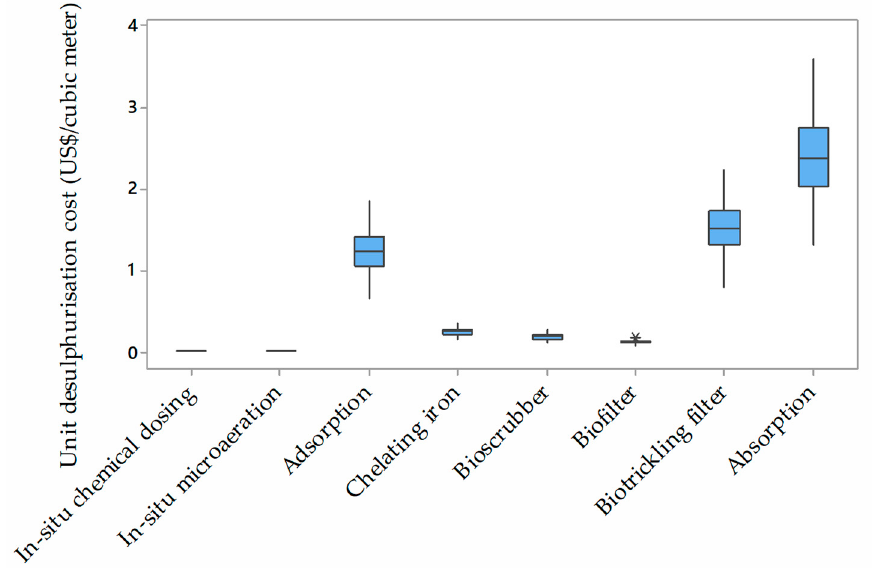
Figure 5. The unit desulphurisation cost distribution for technologies investigated in this paper. The mean unit desulphurisation cost of the desulphurisation technologies were investigated and their associated standard deviation are also presented. These values have been estimated for 50% to 150% changes in the estimated operating cost and capital cost components.